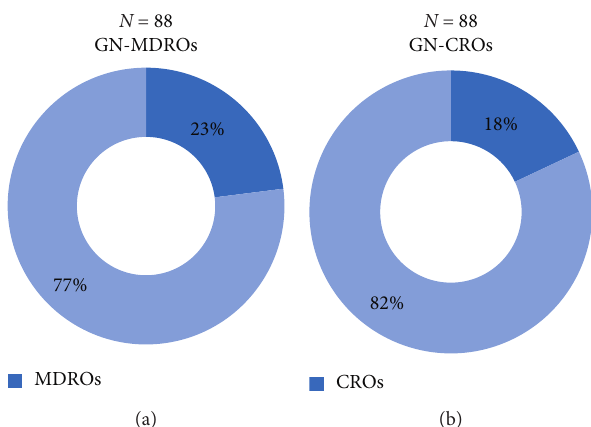
Figure 2: Proportion of Gram-negative multidrug-resistant microorganisms. ∗ Available data of 88/104 cultures. ∗ ∗ GN-MDROs, multidrug-resistant Gram-negative microorganisms; GN-CROs, carbapenem-resistant Gram-negative microorganisms.